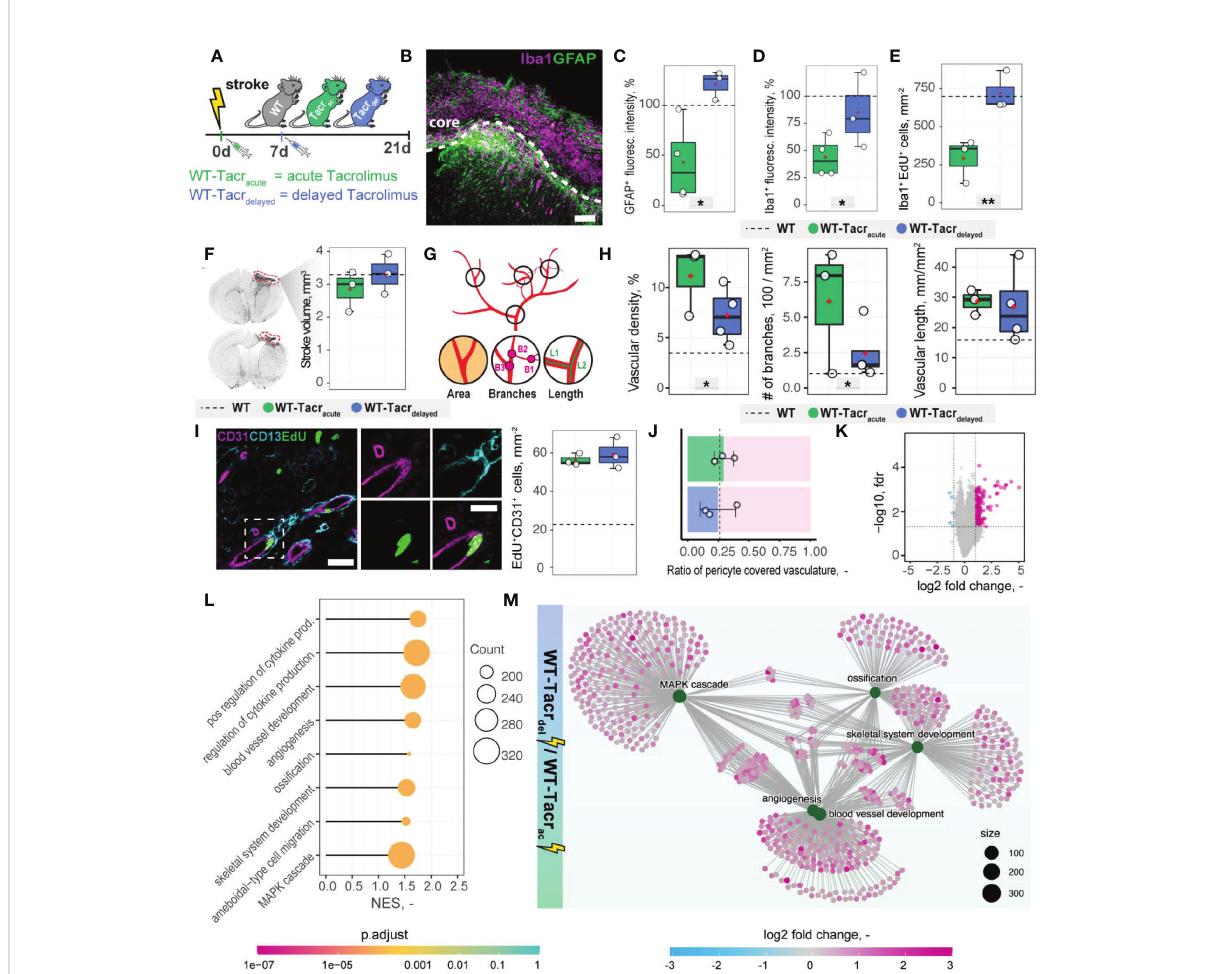
FIGURE 7 Anatomical and gene expression changes in the stroke pathology of acute and delayed pharmacological immunosuppression. (A) Schematic representation of experimental set-up and groups of mice: C57BL/6J wildtype (WT), acute (0 dpi) tacrolimus immunosuppressed wildtype (WT- Tacr acute ), and delayed tacrolimus (7 dpi) immunosuppressed wildtype (WT-Tacr delayed ) mice. (B) Representative image of Iba1 + in fl ammatory cells (Iba1, magenta) and reactive astrocytes (GFAP + , green) in the ipsilesional cortex at 21 dpi. Scale bar: 100 µm. (C) Quanti fi cation of GFAP + , and (D) Iba1 + fl uorescence intensity in the peri-infarct regions at 21 dpi. (E) Quanti fi cation of Iba1 + EDU + cells in per-infarct region. (F) Stroke volume quanti fi cation at 21 dpi. (G) Schematic overview of vascular parameters (H) Quanti fi cation of vascular density, number of vascular branches and vascular length in the peri-infarct region at 21 dpi. (I) Representative image of newly formed blood vessels (CD31 + , magenta) covered by pericytes (CD13 + , cyan) and incorporating a nucleotide analogue that was injected at 7 dpi (EdU + , green). Scale bars: Overview: